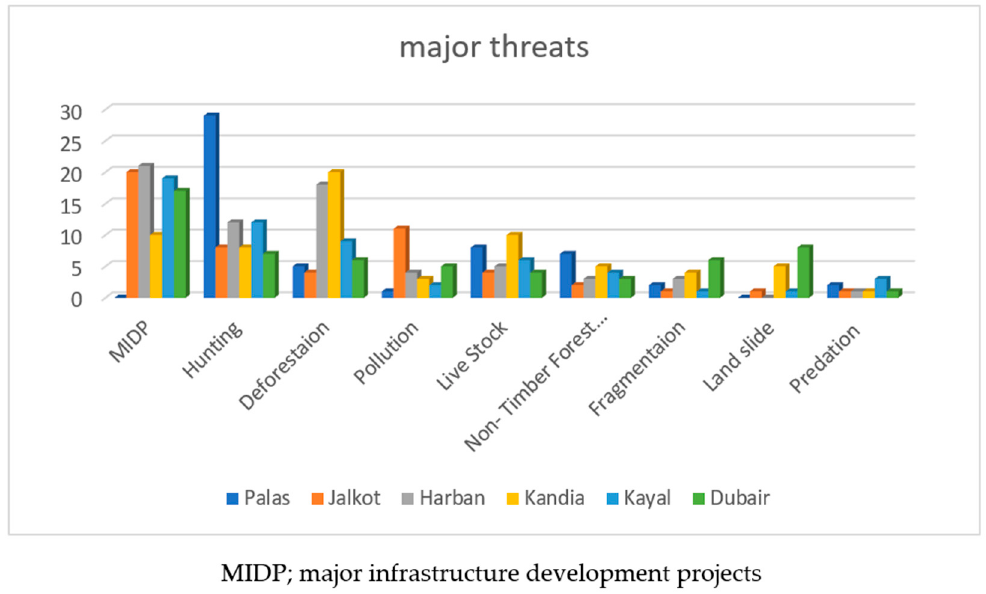
Figure 2. Major threats and their impacts on the pheasant population and their habitats.